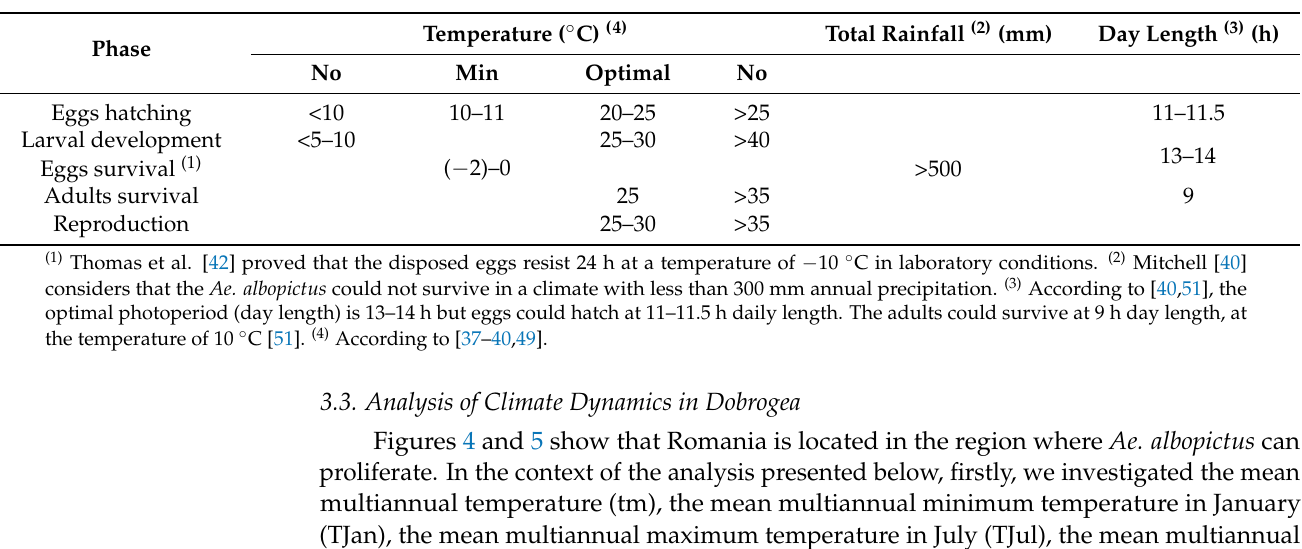
Table 2. Climate condition for development stages of Ae. albopictus.